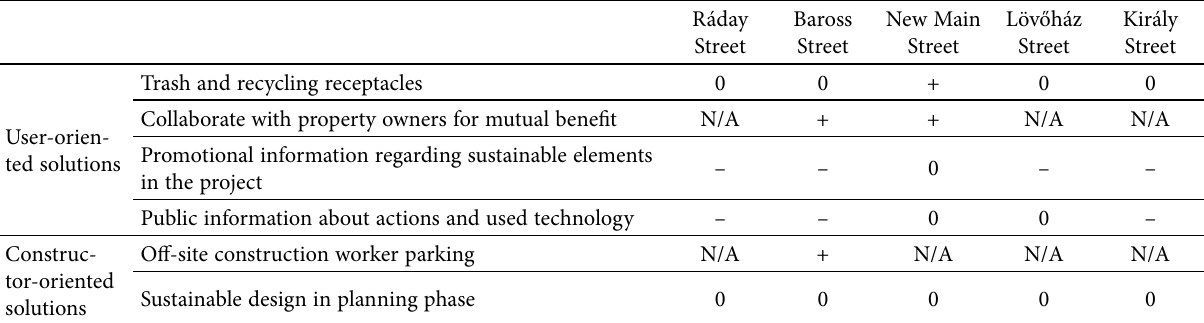
Table 5. Indicators and results regarding awareness